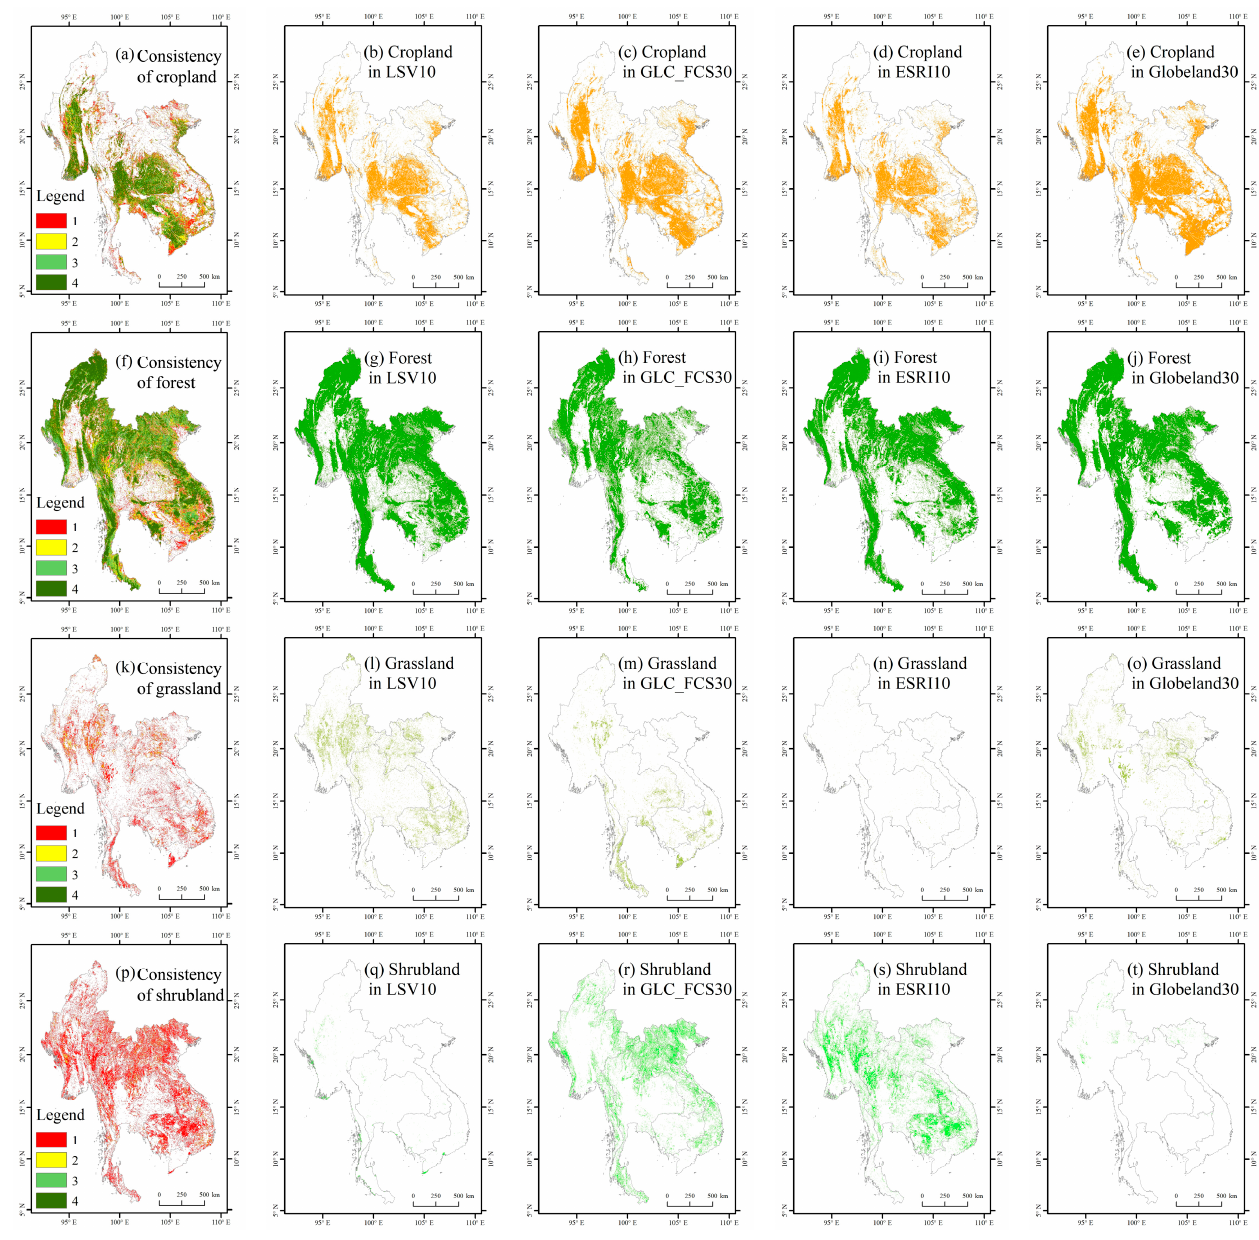
Figure 5. Spatial consistency of different LULC